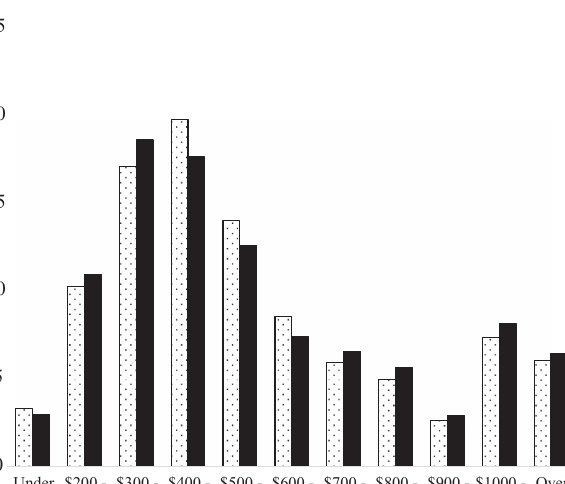
Figure 1. Earnings by industry between 2004 and